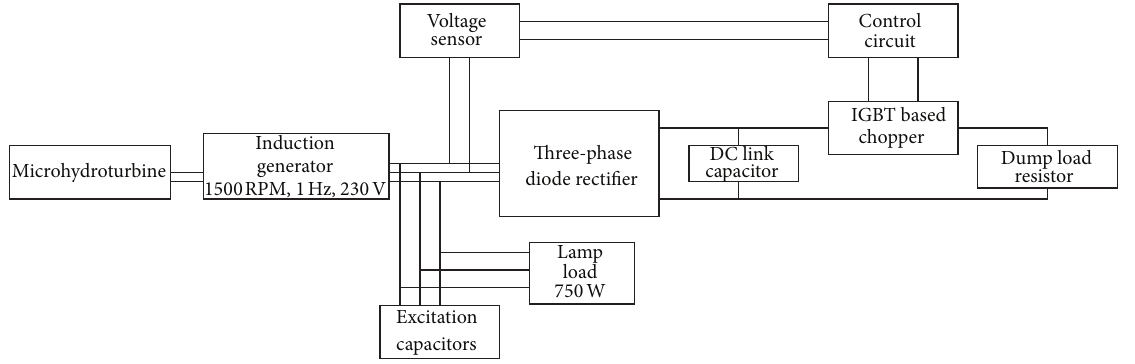
Figure 1: Block diagram of the proposed Improved Electronic Load Controller for